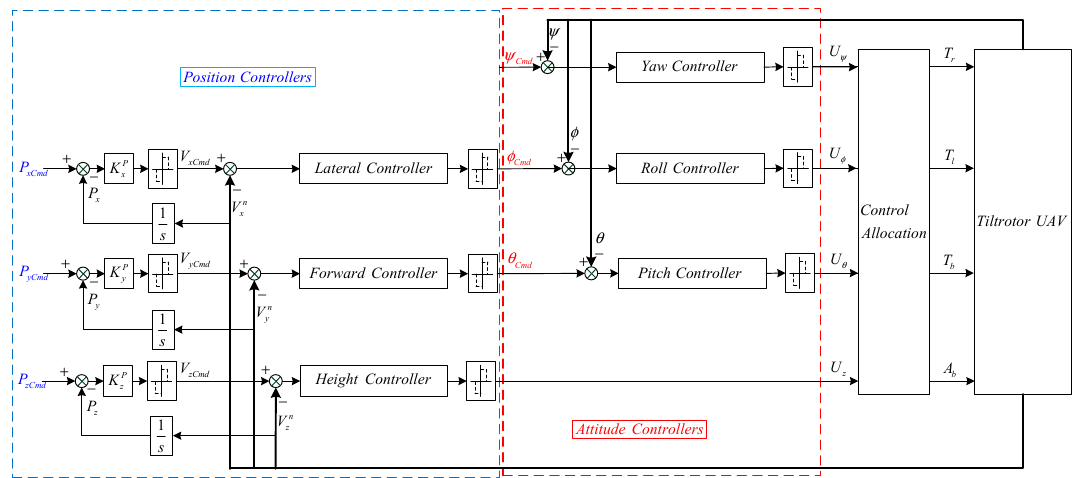
Figure 3. Structure diagram of conventional control scheme in the VTOL phase.